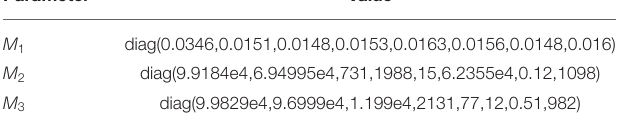
TABLE 3 | Hyper-parameters for GPMPC controller. Parameter